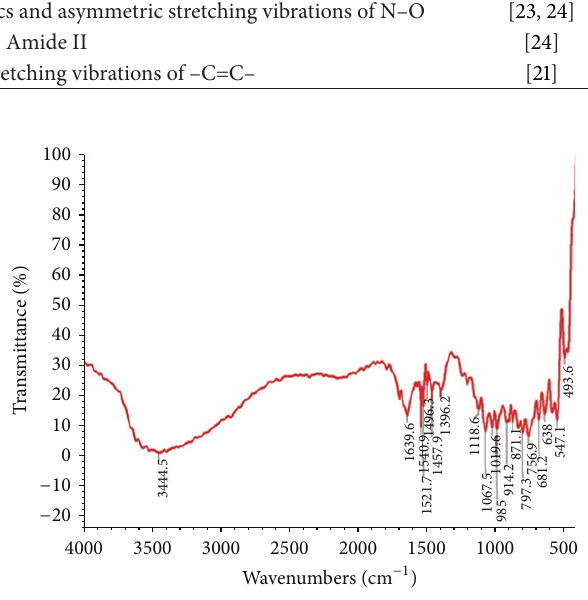
Figure 4: FTIR analysis of synthesized silver nanoparticles from Westiellopsis sp. (A.15). Wavenumbers cm −1 : 1 unit = 500 cm −1 ; % transmittance: 1 unit = 10%